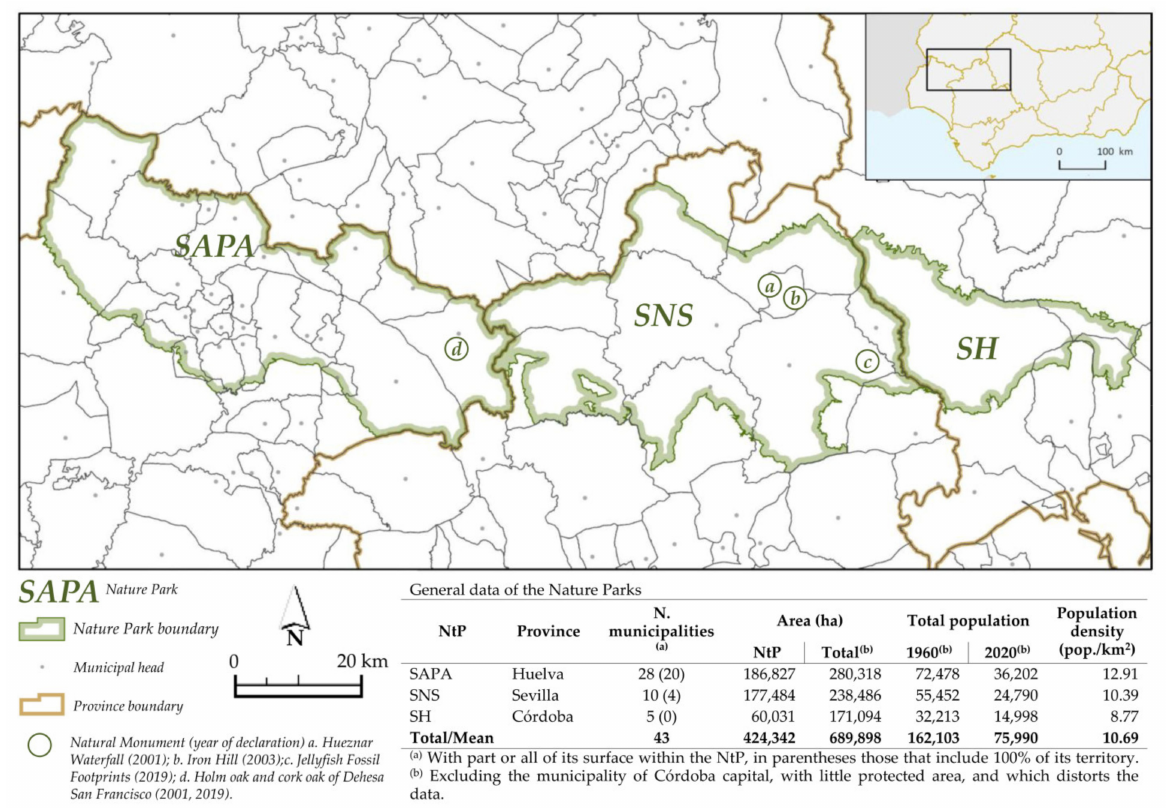
Figure 1. Scope of the study. Source: [80,81]. Authors’